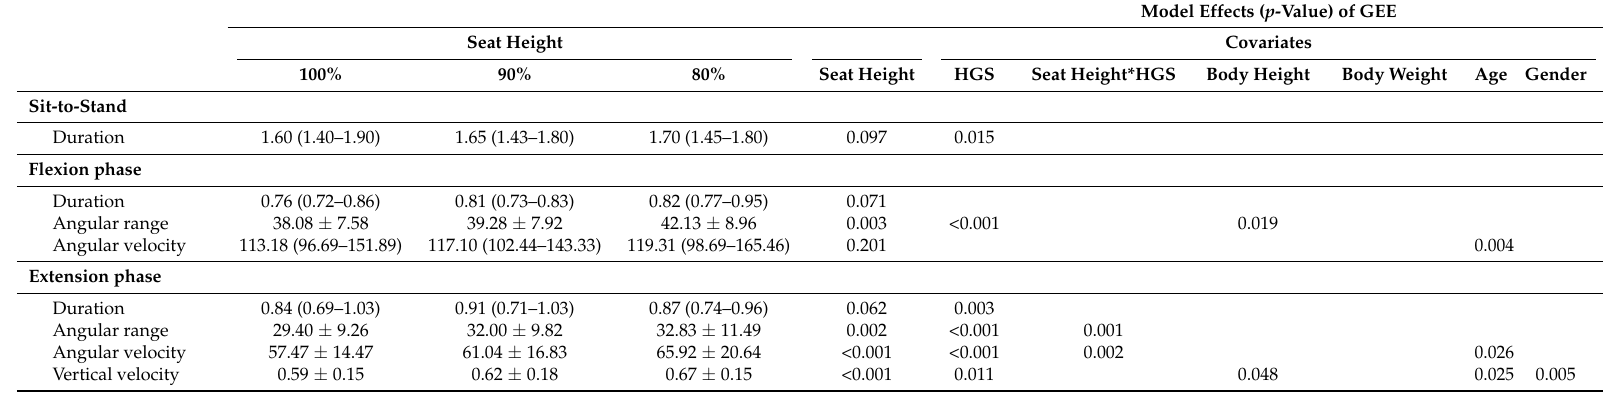
Table 2. Durations (s), angular range ( φ in ◦ ), angular velocity ( ω max in ◦ /s) and vertical velocity (v max in m/s) during flexion and extension of the Sit-to-Stand movement for the three seat heights. Model effects of Generalized Estimating Equations are displayed for the condition factor Seat Height and for the included